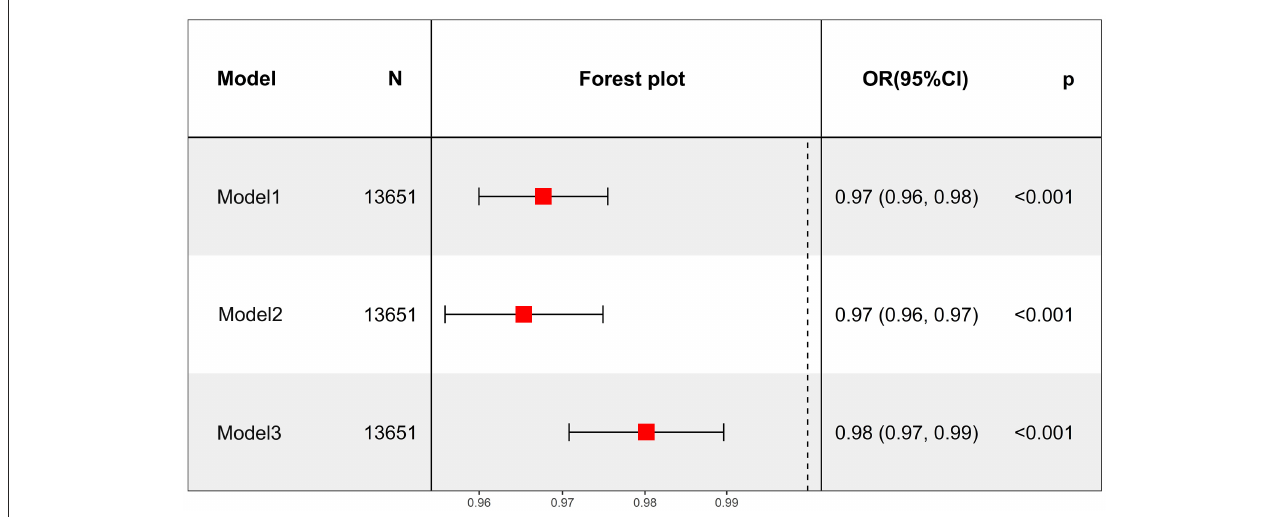
FIGURE2 Average daily smoking in the past 30 days as a continuous variable to analyze the relationship between average daily smoking and depression.